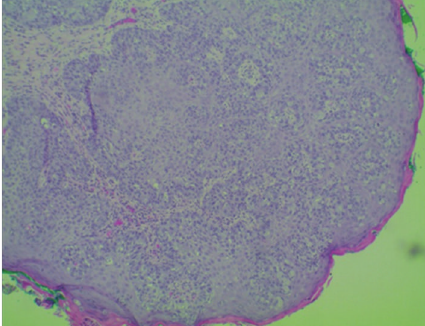
Figure 2: Histological image (low power) of epidermis infiltrated by suprabasal small nests and single epithelial cells with abundant vacuolated cytoplasm highlighted by mucicarmine special stain.